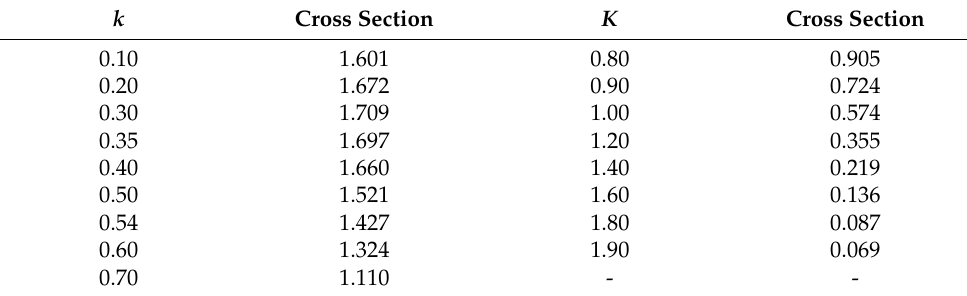
Table 10. Photoionization cross sections (10 − 18 cm 2 ).